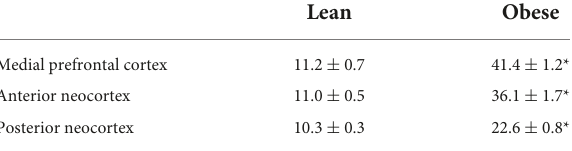
TABLE 3 2-AG levels (nmol/g tissue) in individual brain cortical regions as depicted in Figure 1 . Lean